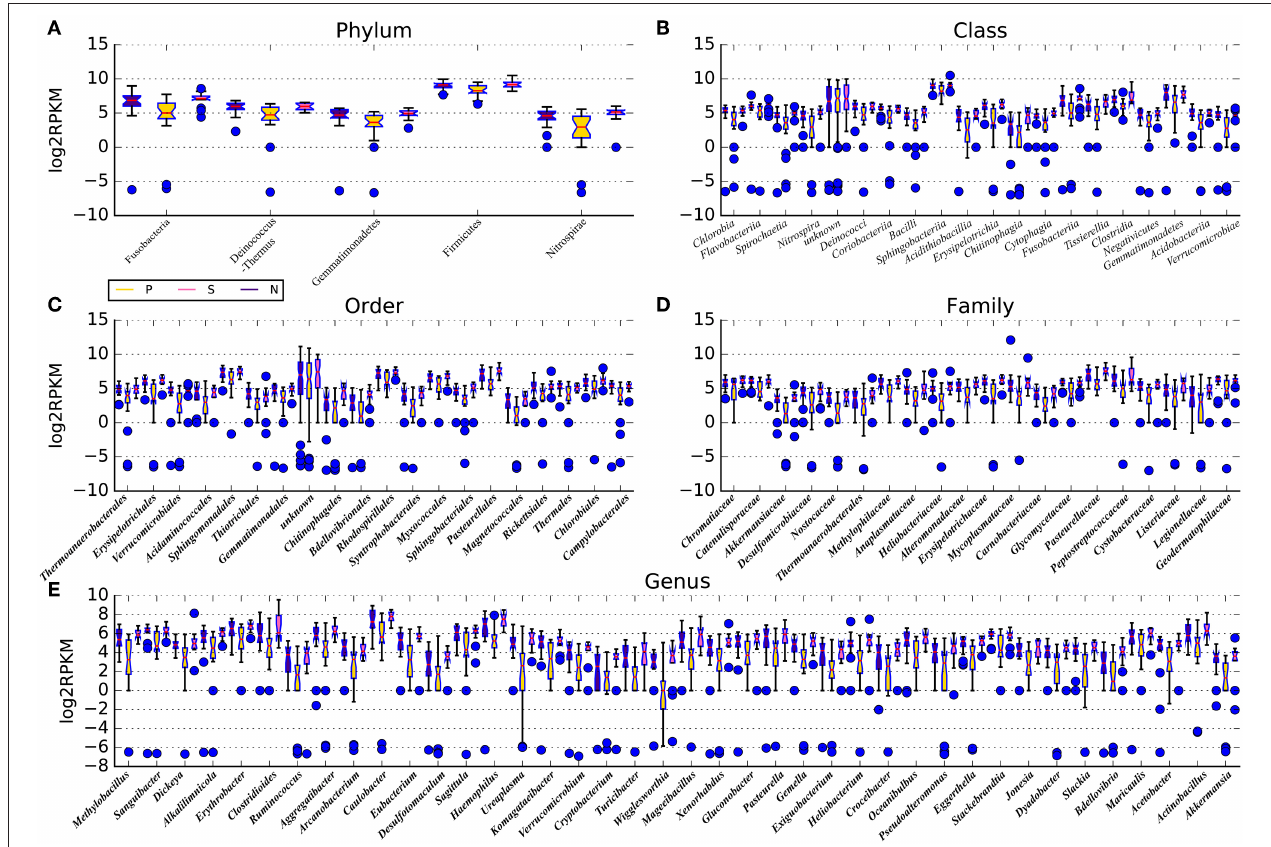
FIGURE 2 | Microbiota composition of BALF samples in IPF and healthy subjects. The microbiota in IPF patients and healthy subjects (including smokers and non-smokers) were shown at the phylum (A) , class (B) , order (C) , family (D) , and genus (E) levels. Species with a median relative abundance larger than 0.01% of the total abundance in either the control group or the IPF group were included for comparison. P stands for IPF group, N stands for non-smoking normal subjects, S stands for smoking normal subjects. All results are presented as the median, the 25–75 % percentiles and the variation range; results for IPF group (P) are presented as yellow boxes, smoking control subjects (S) are marked with pink boxes and non-smoking control subjects (N) are marked with violet boxes. Blue dots represent the abnormal observations at the corresponding taxonomic